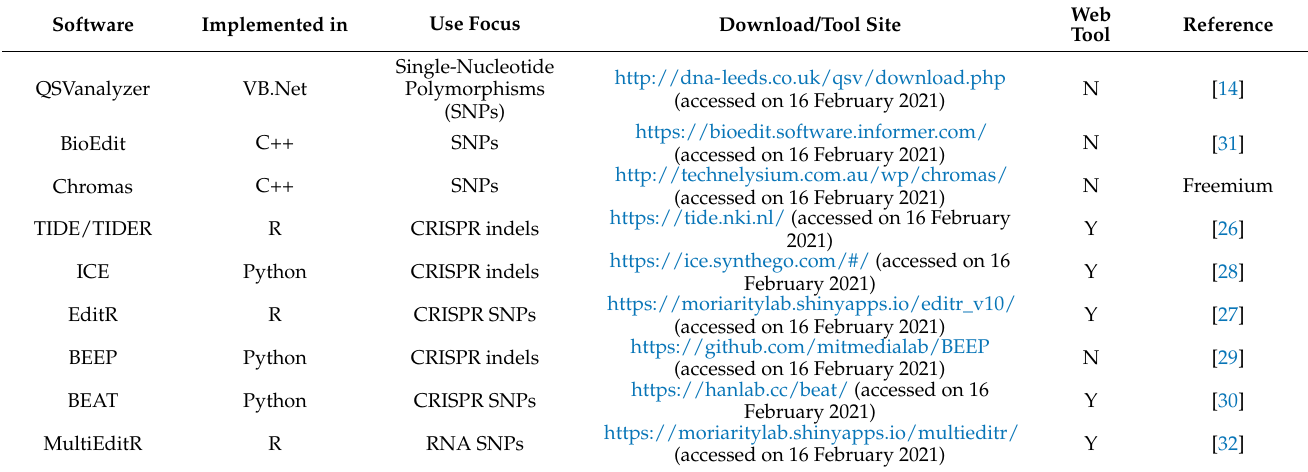
Table 1. Free software for estimating copy-number proportions based on Sanger